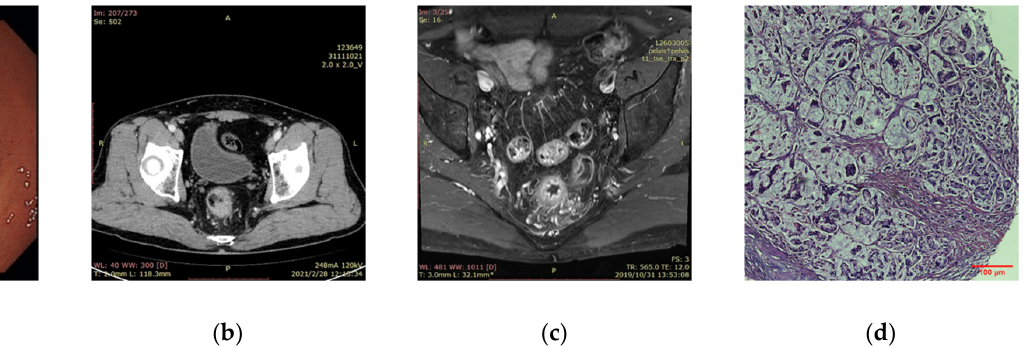
Figure 3. Common CRC image types. ( a ) Endoscopy; ( b ) CT; ( c ) MRI; ( d ) pathology image (the